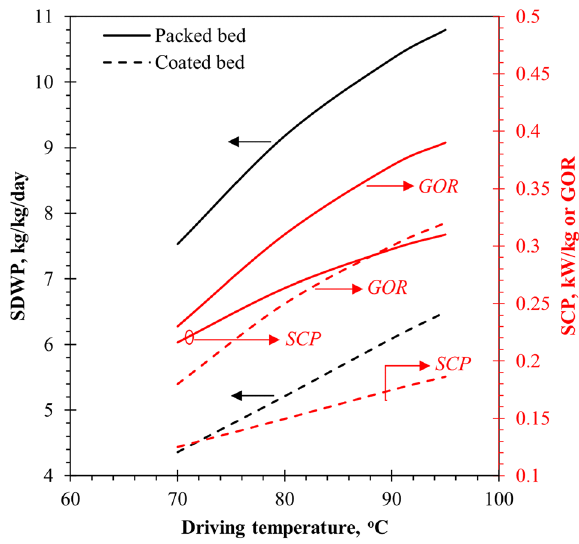
Fig. 4 SCP, SDWP, and GOR variations for the two beds at different driving temperatures. Regeneration temperature steadily increases SCP, SDWP, and GOR values of both